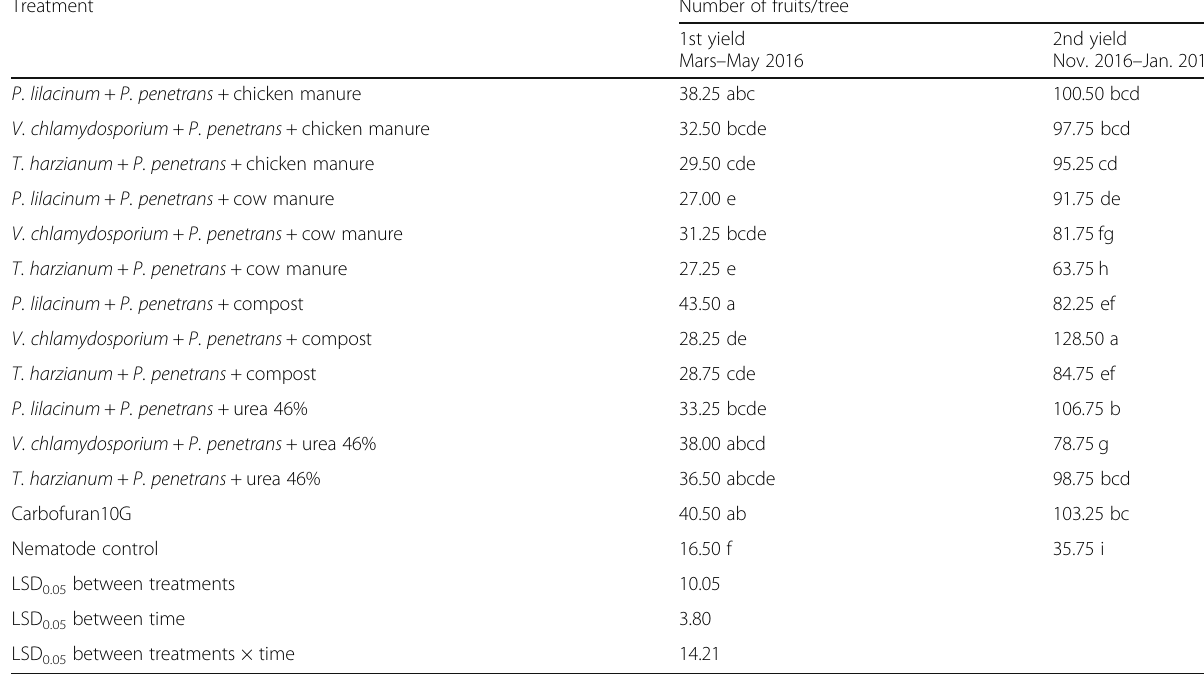
Table 5 Effect of different combinations of integrated control measures on the number of fig, Ficus carica , fruits Treatment Number of fruits/tree